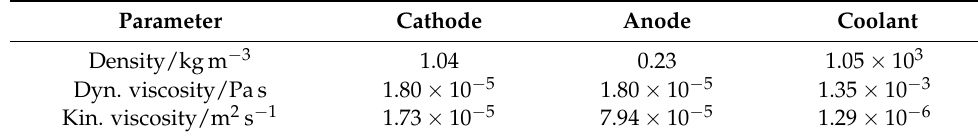
Table 2. Fluid properties at 65 ◦ C for the CFD